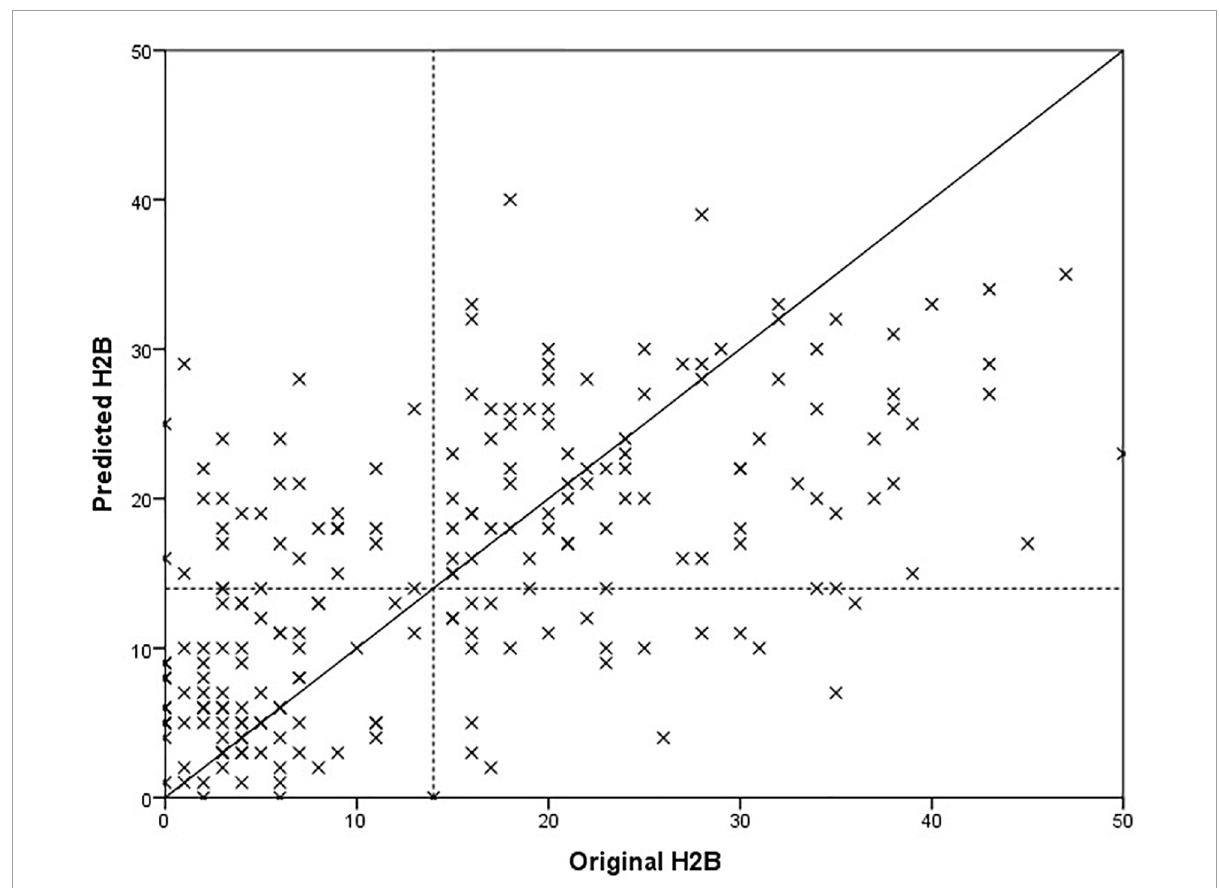
FIGURE2 Comparison of predicted and original depression severity scores, when the BDI score was used for training.